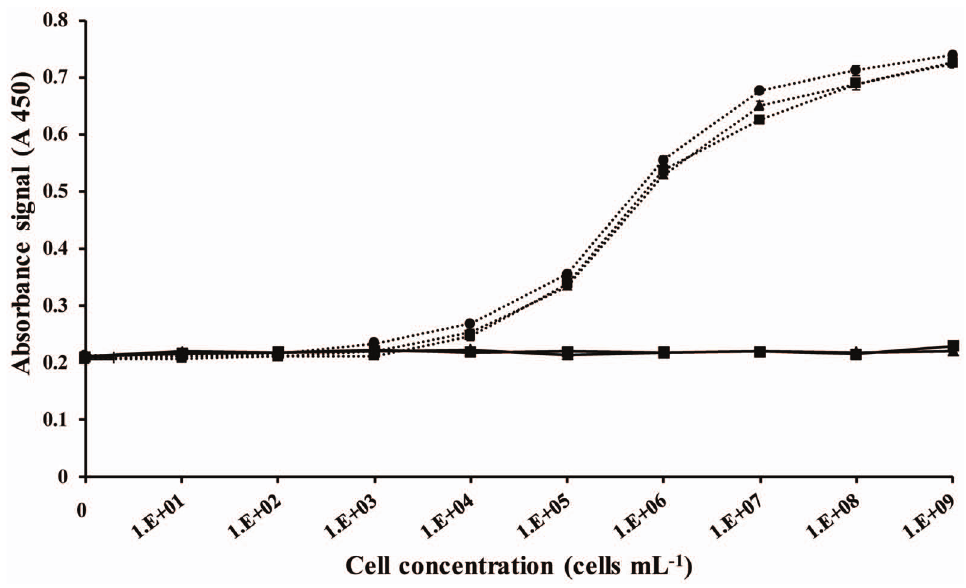
N ) natural seawater.